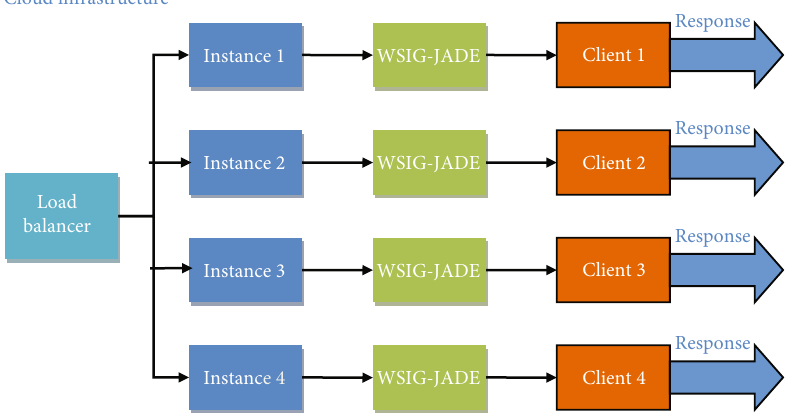
Figure 18: Load balancing of JADE-WSIG with multiple